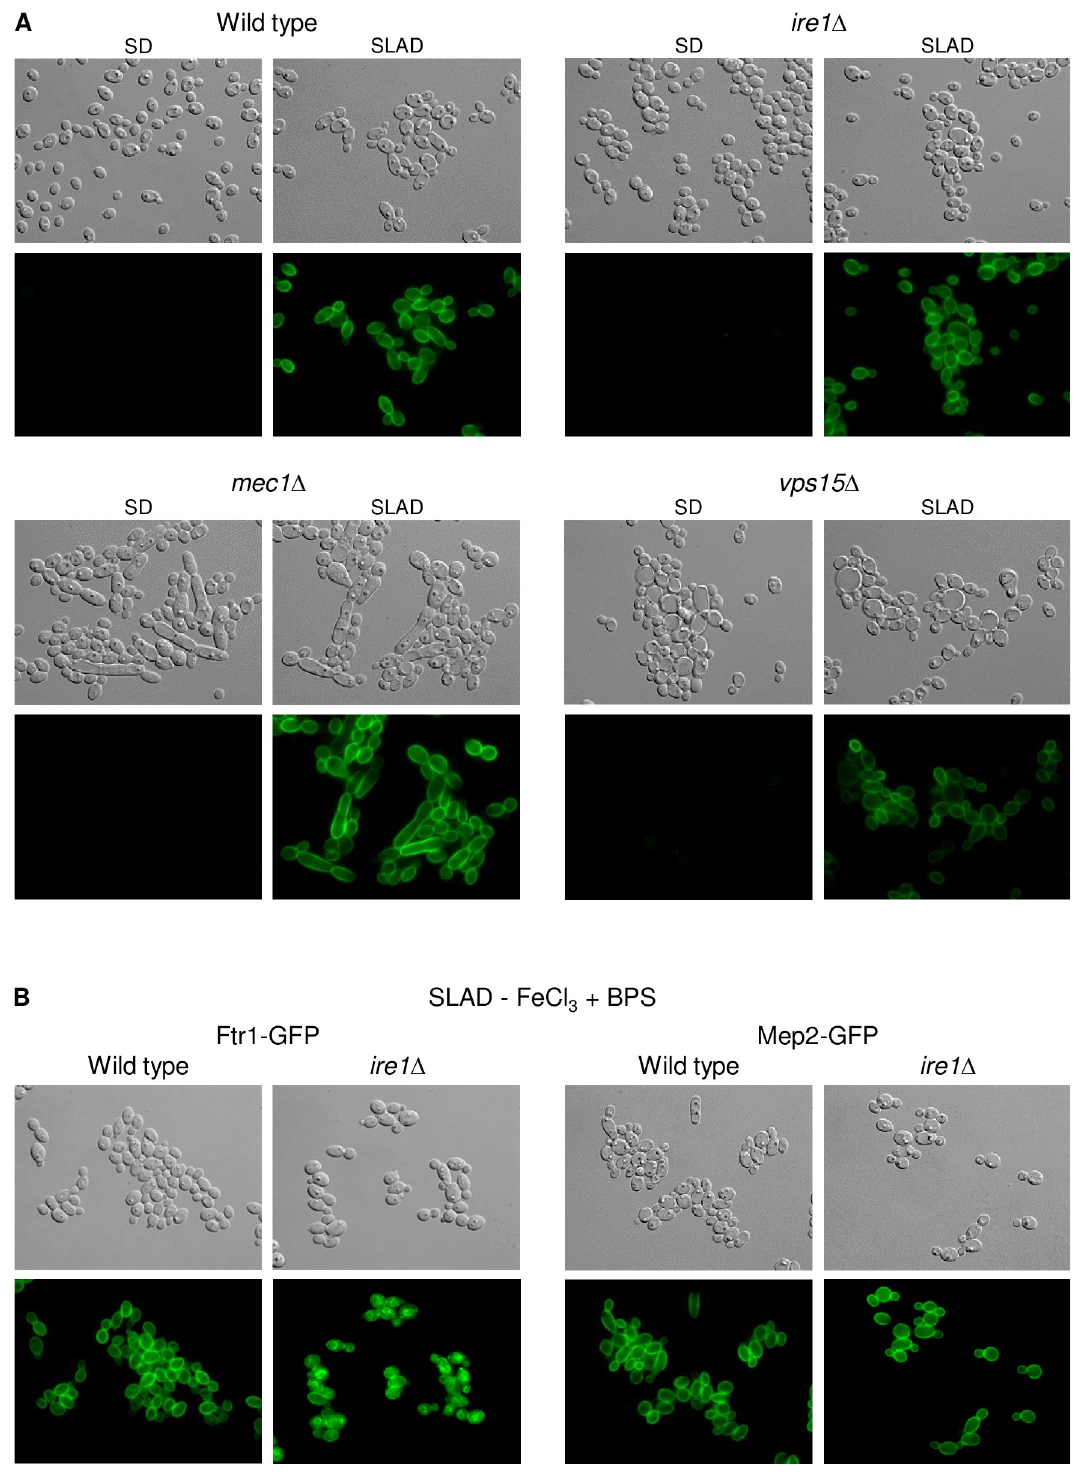
Fig 8. Ire1 is not required for correct localization of the ammonium permease Mep2 in response to nitrogen limitation. (A) Overnight cultures of the wild-type strain SC5314 and ire1 Δ , mec1 Δ , and vps15 Δ mutants carrying a GFP -tagged MEP2 allele were inoculated in SD or SLAD medium and grown for 5 h at 30˚C. Cells were imaged by DIC and fluorescence microscopy. The two independently generated series of strains behaved identically and only one of them is shown. (B) The wild type and ire1 Δ mutants with GFP -tagged FTR1 or MEP2 alleles were grown in SLAD medium without iron and the cells observed as described above.